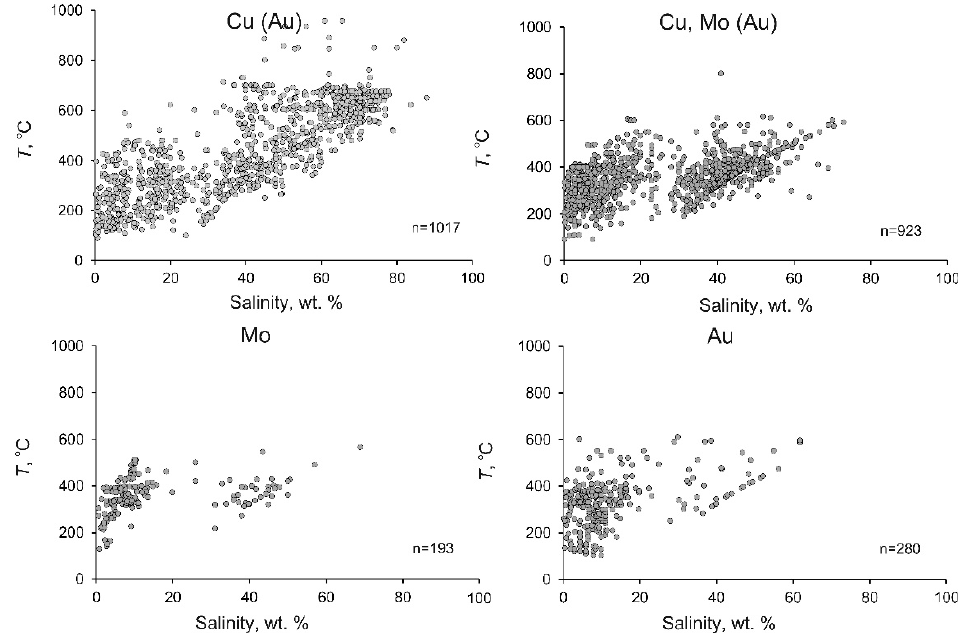
Figure 8. Temperature–salinity diagram for mineralizing fluids at porphyry deposits of different types.